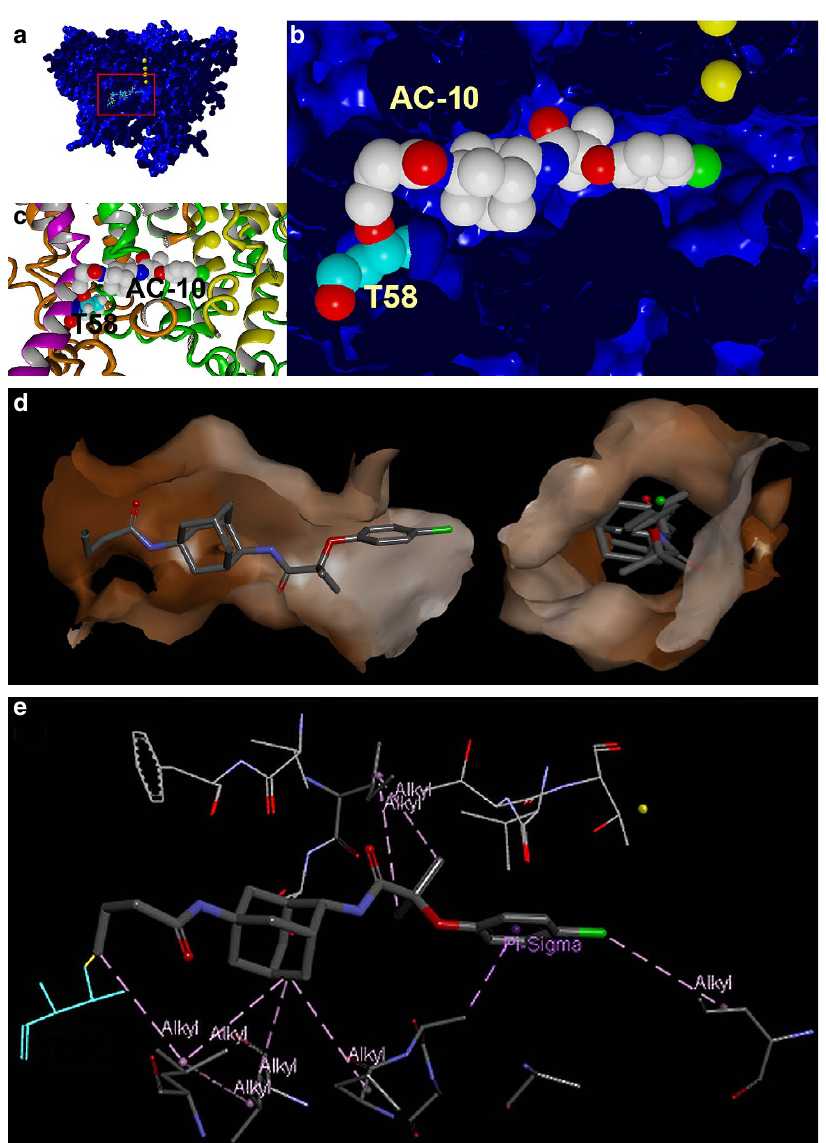
Figure 8 | Constrained docking of AC-10 to Kv7.1 channel. ( a ) AC-10 carbene docked by constraining the distance (2 ± 1Å) to the KCNE1 Thr58 side chain. The energy minimized model complex is shown. Kv7.1/KCNE1 was surface rendered, cut in the middle and colored blue, KCNE1 Thr58 is presented in ball-representation and CPK color coding with carbons in cyan. Compound AC-10 is shown in ball-representation and standard CPK color coding. K þ -ions are shown as yellow spheres. ( b ) Close-up of AC-10 in its binding pocket. ( c ) Close-up representation of similar region, but with protein shown as ribbons (KCNE1 in magenta, Kv7.1 subunits in yellow green orange). ( d ) The AC binding site is formed by several residues that surround a tunnel-like structure (fenestration) that bridges the inner cavity (left) and the membrane (right). The surface lining the fenestration is hydrophobic, especially in the region around the adamantine of AC-1. ( e ) The specific ligand-receptor interactions determined using Discovery Studio 4.0. are: six alkyl interactions (pink), one alkyl-pi interaction (pink) and one carbon interaction